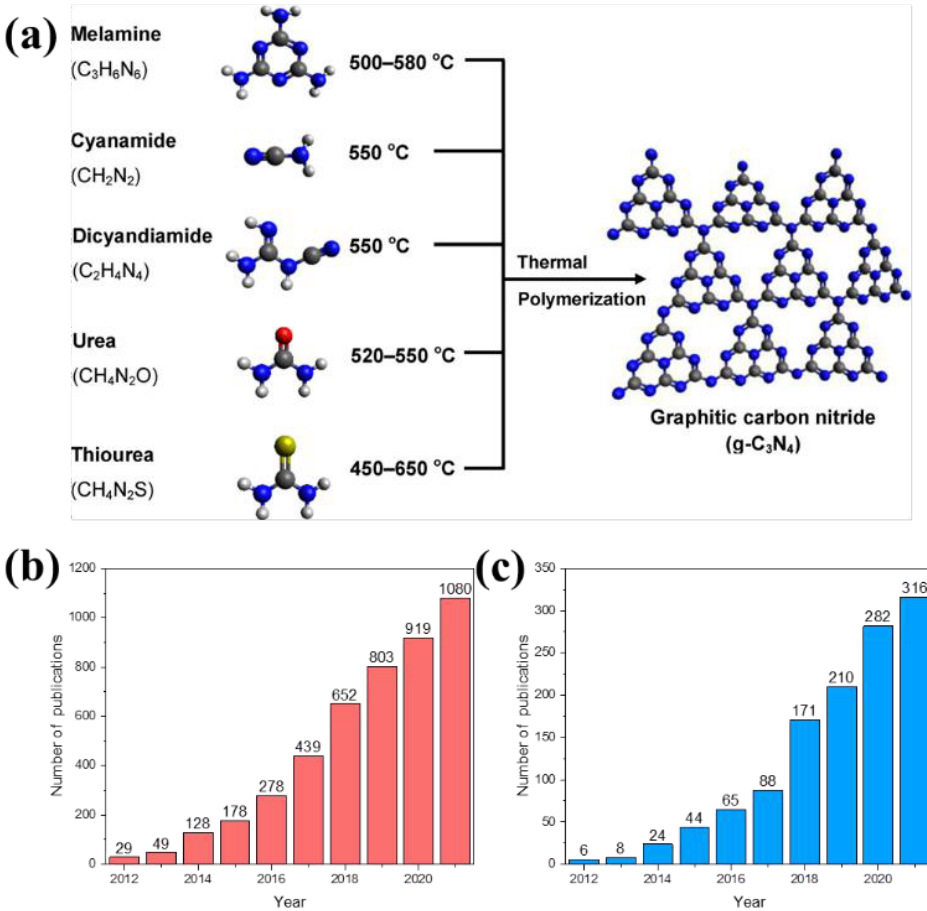
Figure 1. ( a ) Schematic illustration of the synthesis process of CN by polymerization of different precursors [20]. ( b ) Number of annual publications using “photocatalytic” and “carbon nitride” as topic keywords since 2012. ( c ) Number of annual publications using “photocatalytic”, “carbon nitride” and “doping” as topic keywords since 2012. Adapted from ISI Web of Science, dated August 2022.